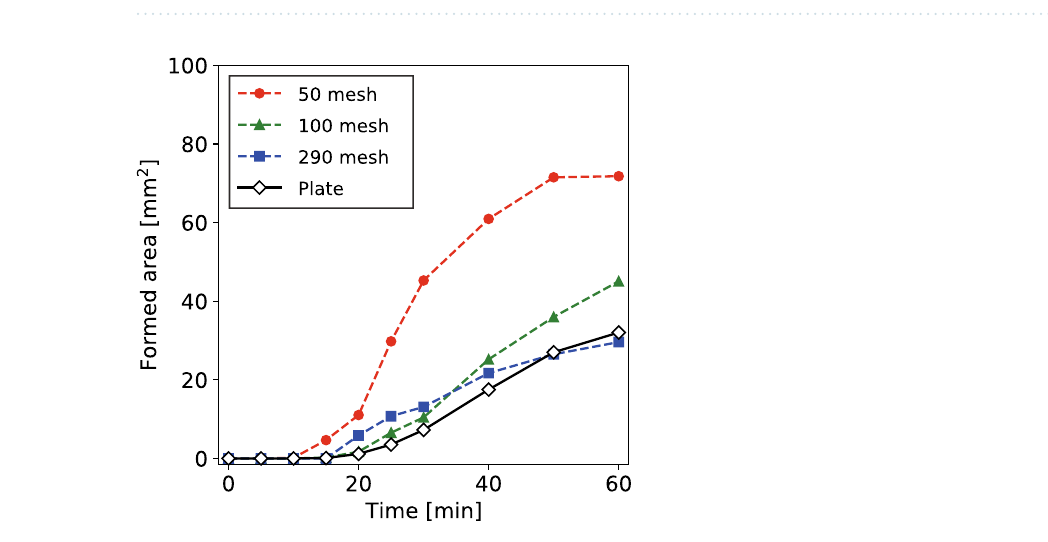
Figure 5. LFN growth area profiles at 20, 40, and 60 min on ( a ) the W-plate, ( b ) ♯ 290 , ( c ) ♯ 100 , and ( d ) ♯ 50 W-mesh, respectively.